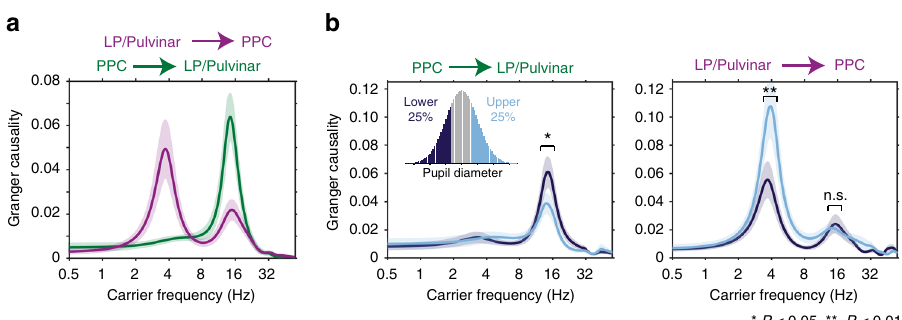
Fig. 4 Arousal level determines the direction and carrier frequency of thalamo-cortical causal interaction. a Spectrally resolved Granger causality shows the carrier frequencies of directed interaction from LP/Pulvinar to PPC (magenta), and PPC to LP/Pulvinar (green, ±SEM). LP/Pulvinar has a causal in fl uence on PPC in the theta and alpha frequency bands. In the opposing direction, PPC has a causal in fl uence on LP/Pulvinar in the alpha band. b Granger causality was measured for time periods where the pupil diameter was small (<25%, dark blue) and large (>25%, light blue), respectively. Data were subsampled to match power distributions between conditions. The causal in fl uence of PPC alpha oscillations on LP/Pulvinar was signi fi cantly stronger during small pupil diameter epochs (left plot, P = 0.018, t -test). In contrast, the causal in fl uence of LP/Pulvinar theta oscillations on PPC was signi fi cantly greater during large pupil diameter epochs (right plot, P = 0.0015,